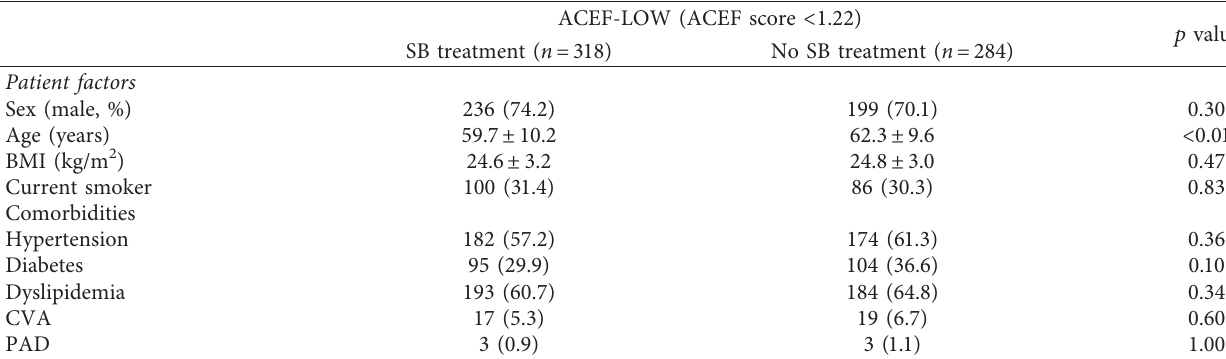
Table 2: Baseline characteristics according to SB treatment in the low-risk